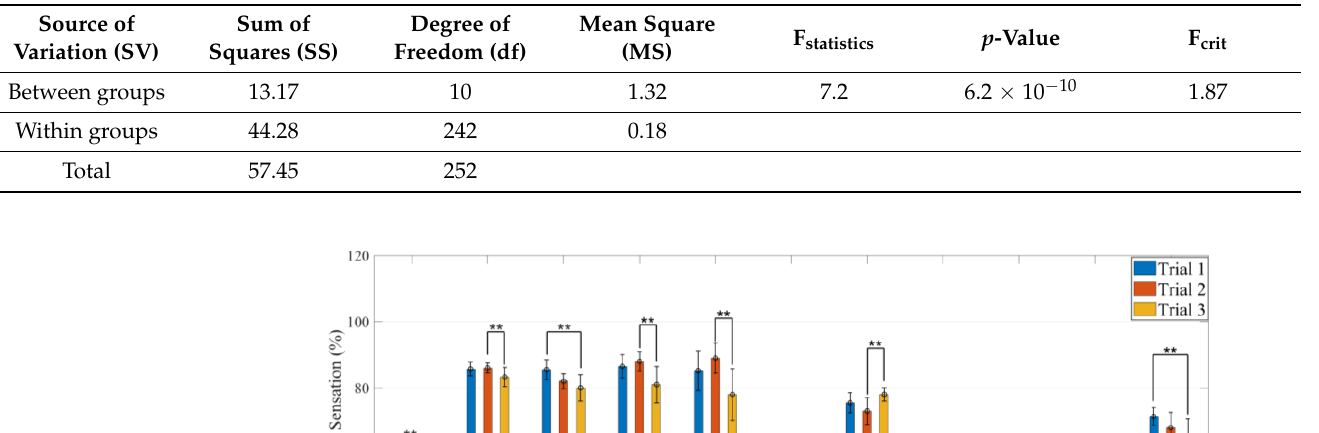
Table 4. Single-factor ANOVA taste.